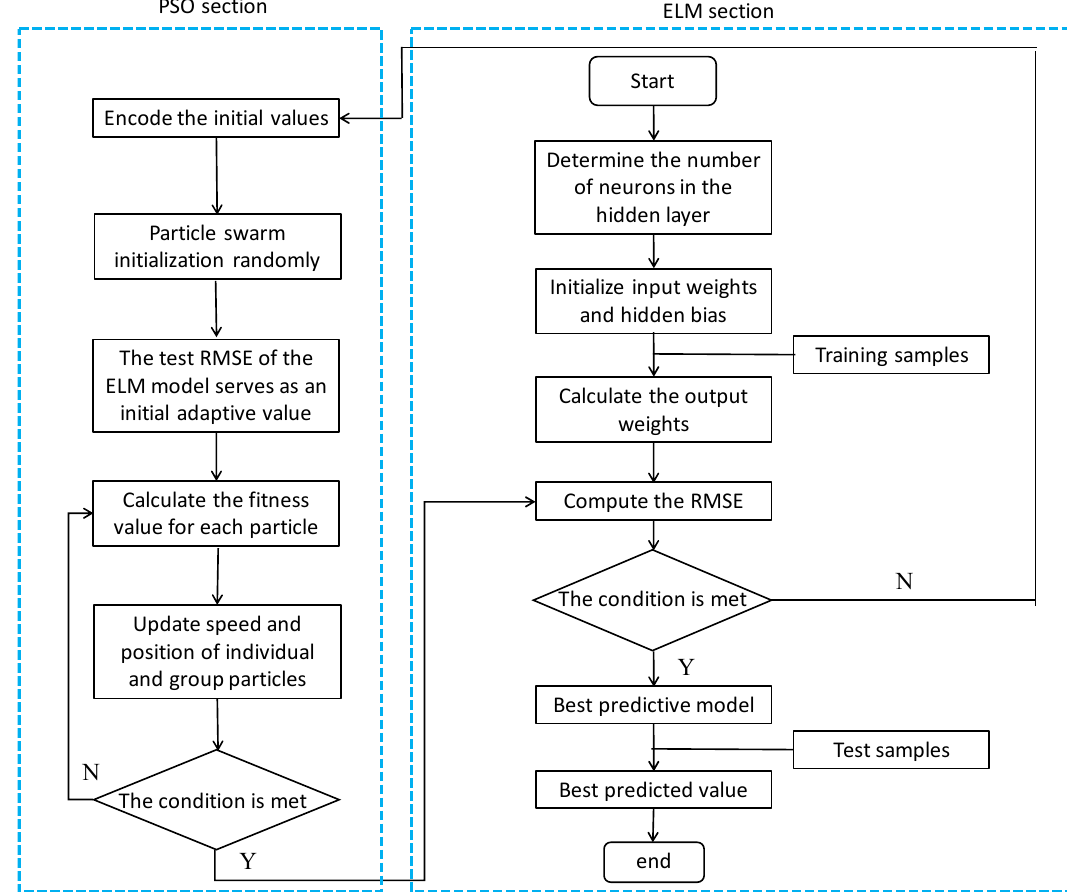
Figure 1. The process of the Elm model optimized by the PSO algorithm.